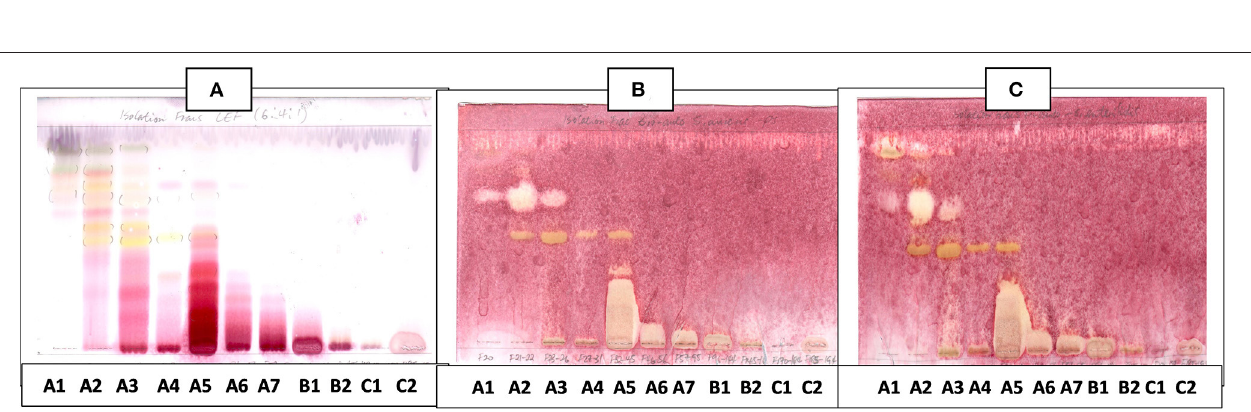
FIGURE 5 | (A) Chromatogram developed in CEF [chloroform: ethyl acetate: formic acid (6:4:1)] of 11 combined fractions obtained from the first column sprayed with vanillin. (B) Bioautography of S. aureus of the 11 combined column fractions–TLC plate developed with CEF (6:4:1). (C) Bioautography of S. Enteritidis of the 11 combined column fractions–TLC plate developed with CEF (6:4:1). Yellow and white bands indicate compounds that inhibit bacteria.